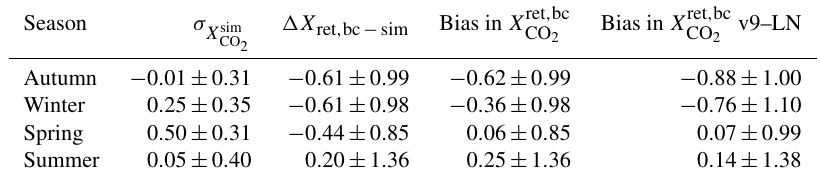
Table 3. Total uncertainty estimates for X sim difference between the first two terms in the middle and left columns. All values are in parts per million. The number on the right in the third column indicates the spatial variability in X ret , bc retrievals, i.e., the v9 data product. Note that, for v9, only land nadir retrievals are analyzed.